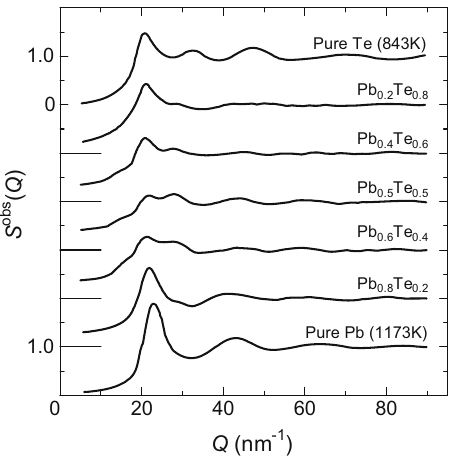
Figure 1: Observed total structure factors,